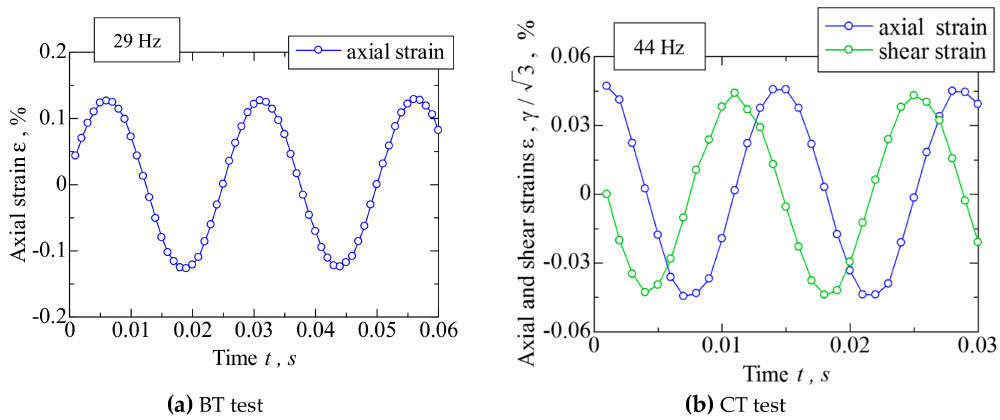
Figure 9. Strain waveforms during fatigue tests, measured using strain